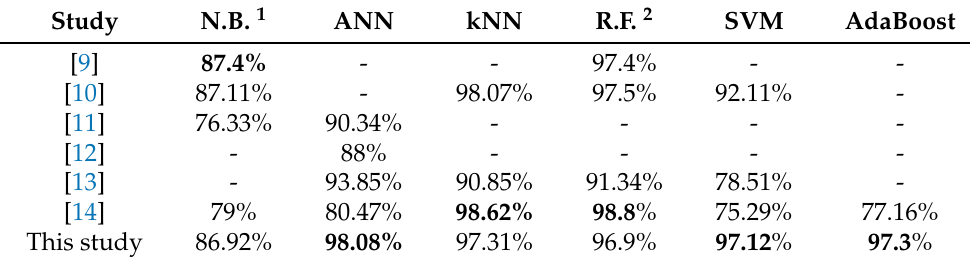
Table 11. Studies Results